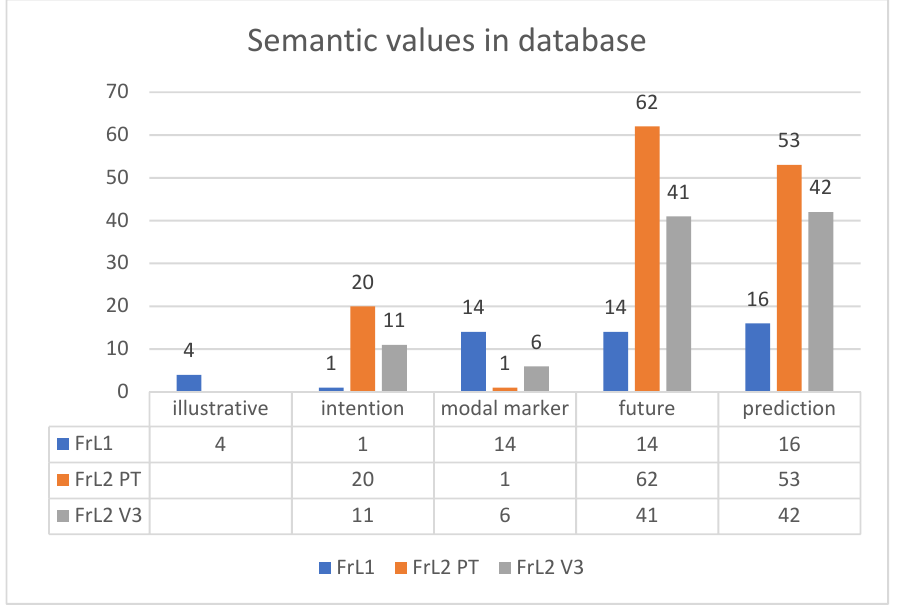
Figure 1. Semantic values in LANGSNAP database.